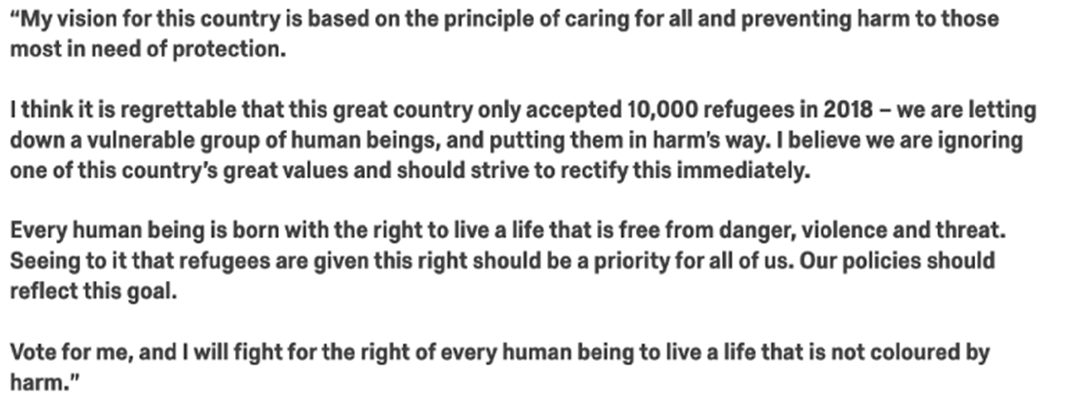
Figure 3. Morally framed policy proposal (care).